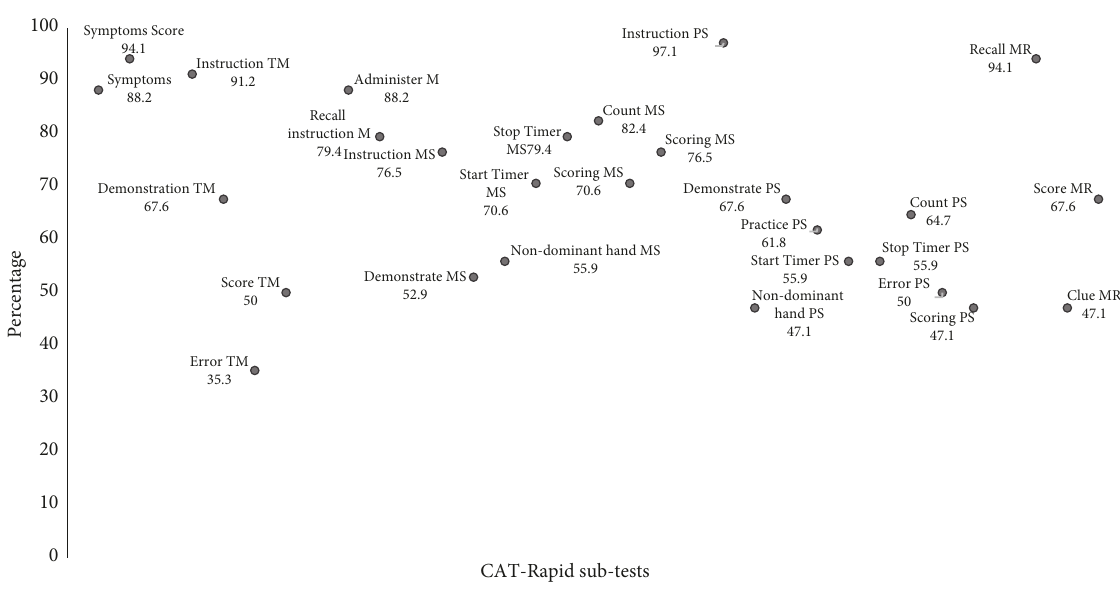
Figure 4: Healthcare workers’ performance of the CAT-rapid subtests.